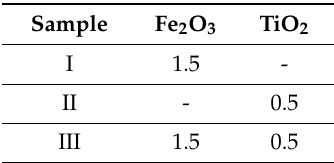
Table 1. The percentages of synthetic pigments added to basic samples of feldspar-quartz raw materials (wt.